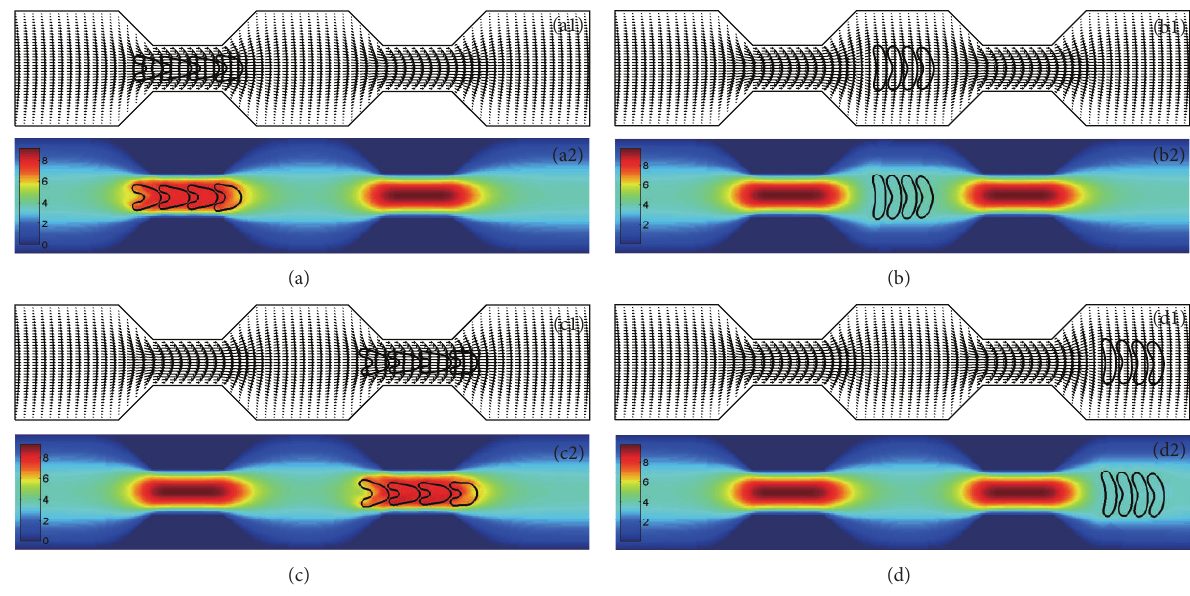
Figure 10: Motion and dissociation of a four-cell erythrocyte aggregate which is vertically placed in a 8 𝜇 m stenotic channel at time instants (a) 𝑡 = 0.46 ms; (b) 𝑡 = 0.86 ms; (c) 𝑡 = 1.23 ms; and (d) 𝑡 = 1.62 ms. Velocity vectors (a1-d1) and axial velocity magnitude contours (cm/s) (a2-d2) are presented. The initial configuration for the aggregate is shown in Figure 1(e), and the aggregate is vertically placed in the channel initially. The parameters used are 𝐷 𝑒 = 1.0 × 10 −2 𝜇 J/m 2 , 𝑘 𝑏 = 3.0 × 10 −12